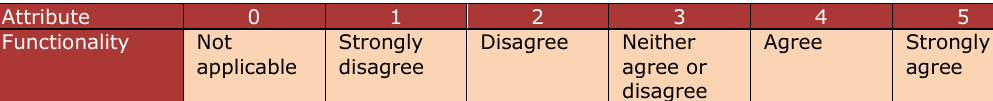
Table 4. Rating criteria description